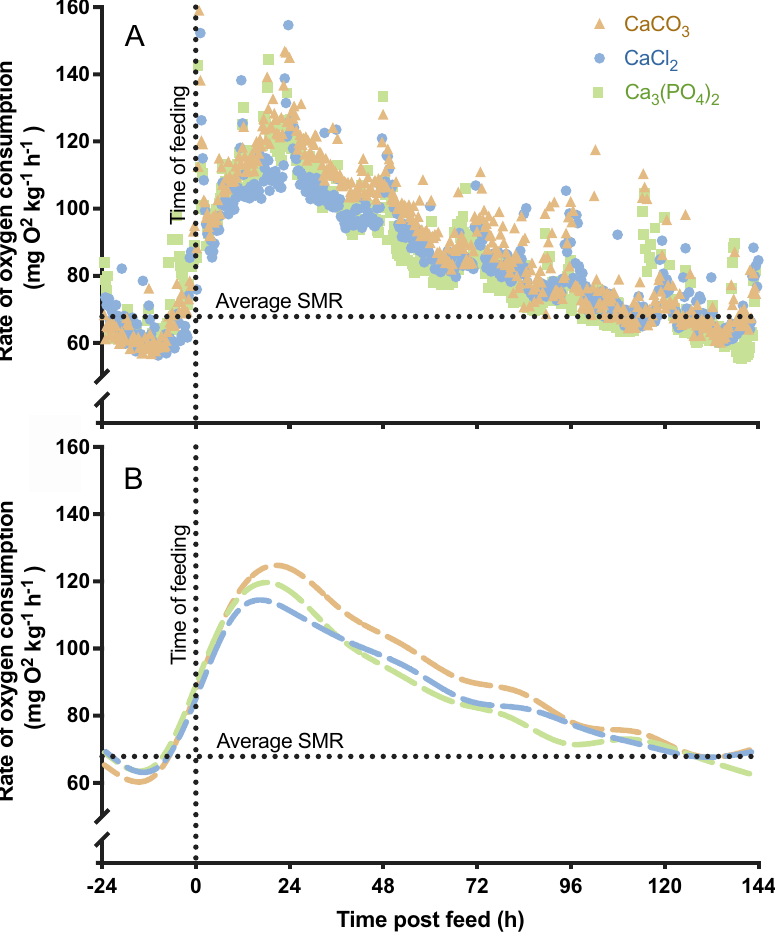
Figure 5. The change in oxygen consumption rate over time in rainbow trout ( Oncorhynchus mykiss ) fed voluntarily on a 2.5% ration of one of three diets supplemented with either CaCl 2 , CaCO 3 or Ca 3 (PO 4 ) 2 (n = 8). Data are presented as mean values for each respirometry cycle time point (A) and smoothed pattern over time using a cubic squared spline (B). The horizontal line represents the average resting (pre-feeding) oxygen consumption of all treatments 24 h prior to feed. The vertical dotted line represents time of feeding.